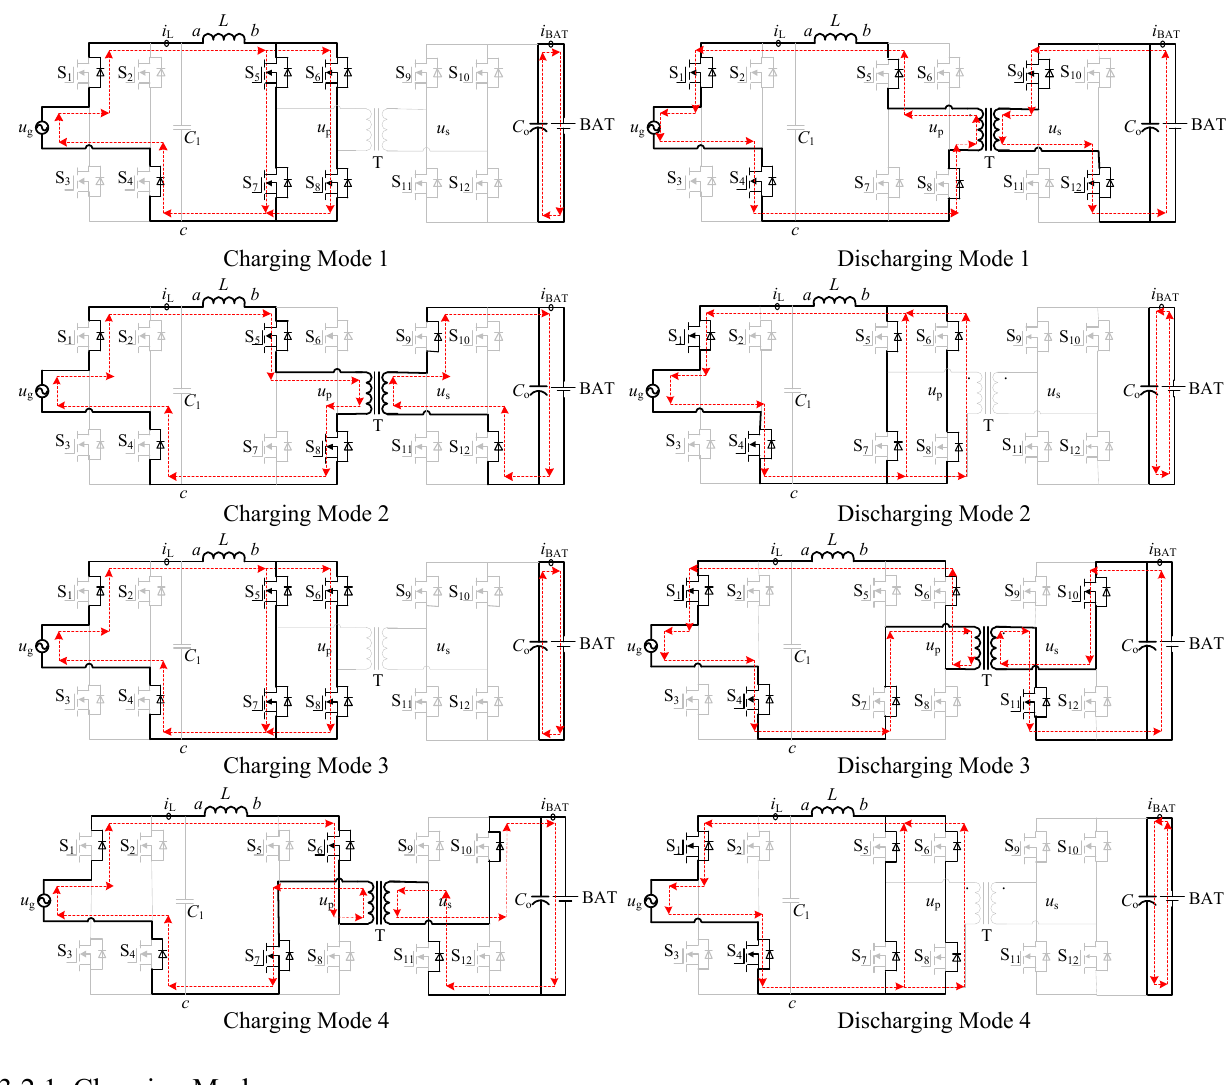
Figure 10. Different operation modes of novel